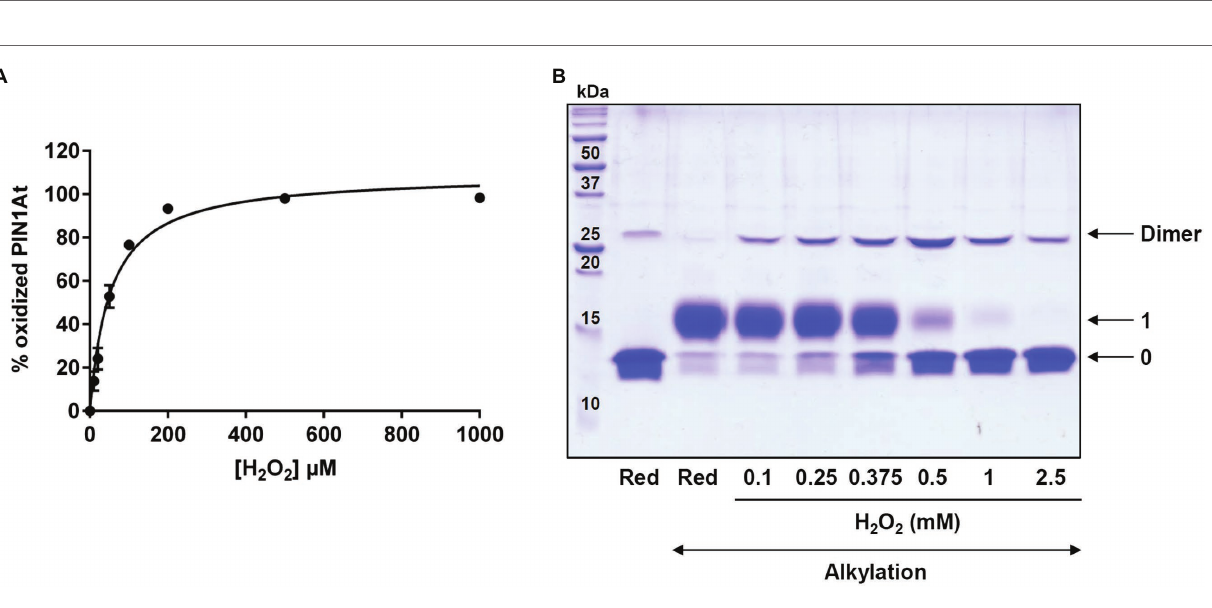
FIGURE 4 | H 2 O 2 -dependent oxidation of PIN1At. (A) PIN1At is sensitive to oxidation by H 2 O 2 . The relative oxidation of 10 μ M PIN1At was evaluated in the presence of increasing concentrations of H 2 O 2 for 30 min. The remaining free thiols were alkylated with mBBr and quantified through measurement of the resulting fluorescence. The decrease of fluorescence was plotted against the oxidant concentration for determination of S 0.5 . The data represent the mean ± SD of three separate experiments. (B) Reduced PIN1At protein (10 μ M) was treated or not with various concentrations of H 2 O 2 for 30 min. After protein precipitation and alkylation of free thiol groups with 2 kDa mPEG-maleimide (except in one reference line), protein mixtures were separated on non-reducing SDS-PAGE 15%. The numbers on the right correspond to the number of thiols that remained reduced upon treatment and thus were alkylated with mPEG